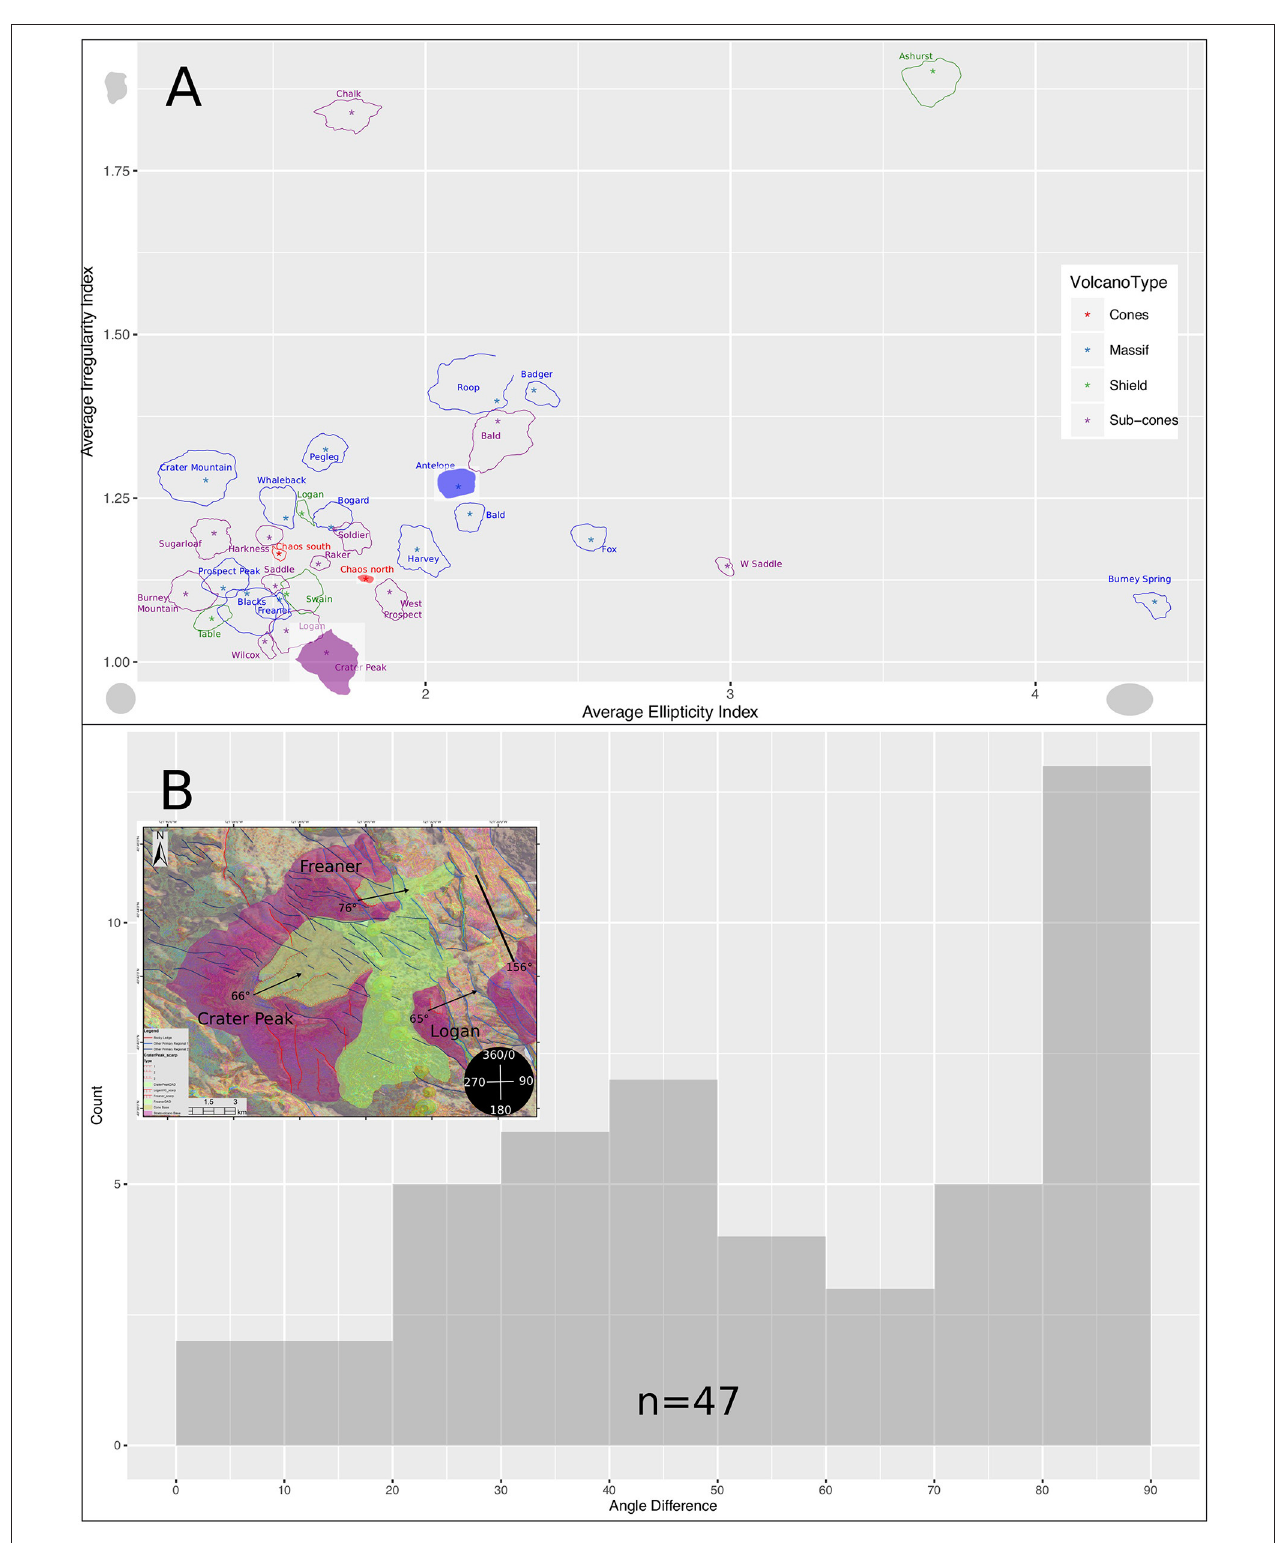
FIGURE 6 | Volcano morphology and breaches. (A) Ellipticity and Irregularity Indices (not to scale) of bigger volcanoes in the Hat Creek Graben region grouped by morphological type as cones, sub-cones, shields and massifs. Filled polygons are those with evidence of collapse scars. (B) Frequency diagram showing the relationship between the opening direction of craters and the maximum horizontal stress. Inset is an example of how angle difference is calculated.